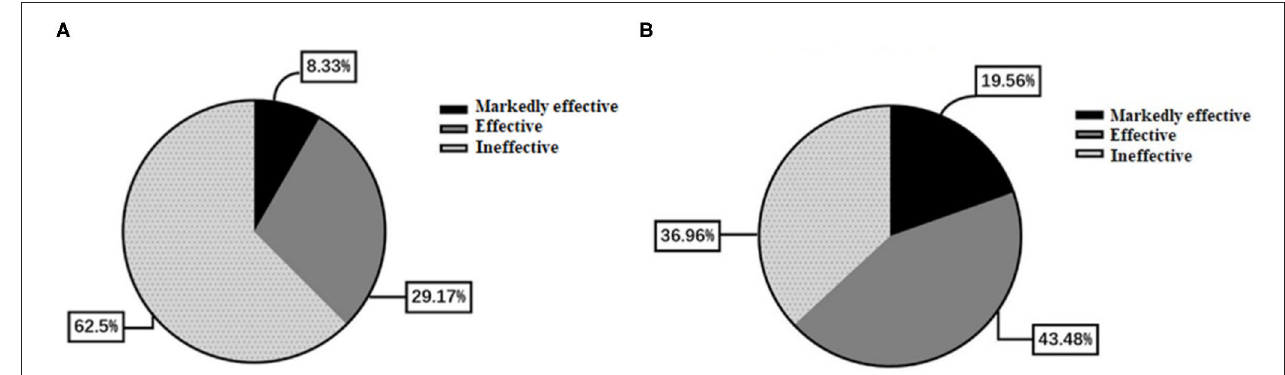
FIGURE 5 | Comparison of effectiveness between the two groups. (A) The conventional treatment group. (B) The butylphthalide